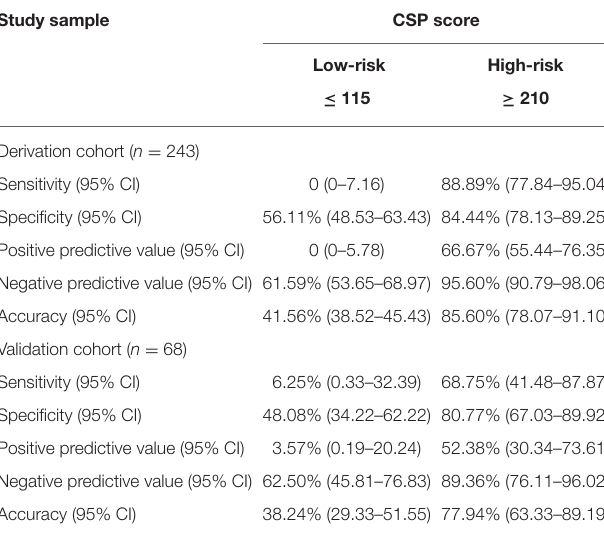
TABLE 4 | Discrimination performance of Cardiogenic Shock Prognosis score with